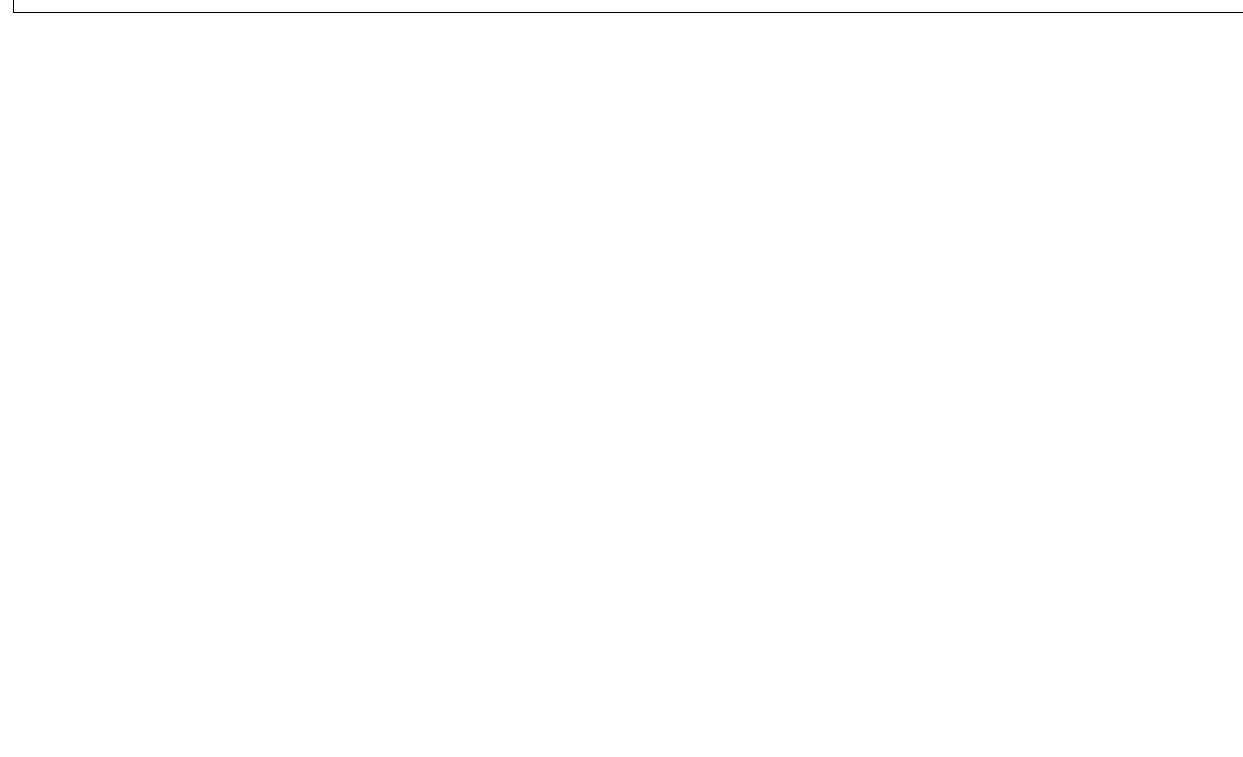
FIGUREA1 | Fixation maps based on the fixation durations for each culture of the observer and each race of the stimuli. Subtracting fixation maps across culture of the observer or race of the stimuli resulted in difference maps. On observers/stimuli maps shown here, white contours